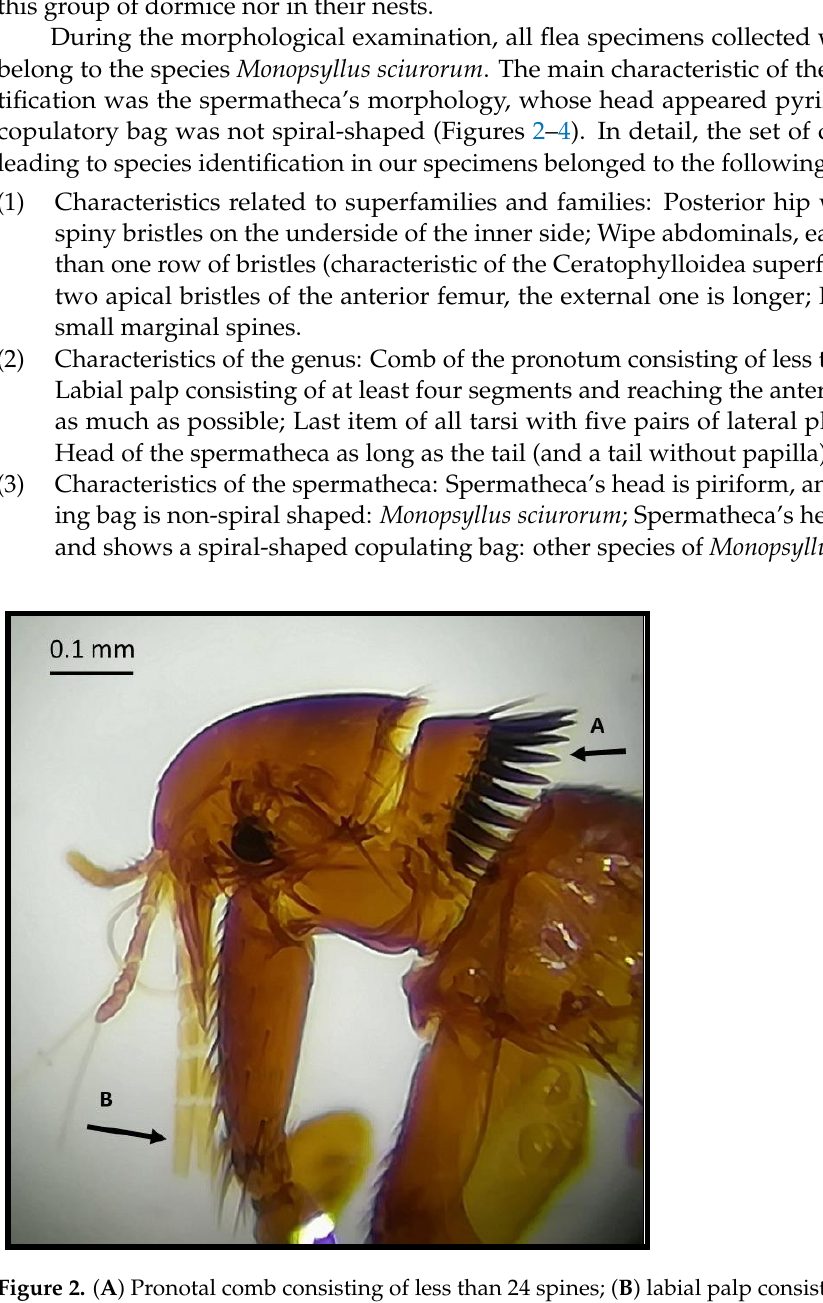
Figure 3. Last article of all tarsi with 5 pairs of lateral plantar bristles ( A ) side view and ( B ) front view).